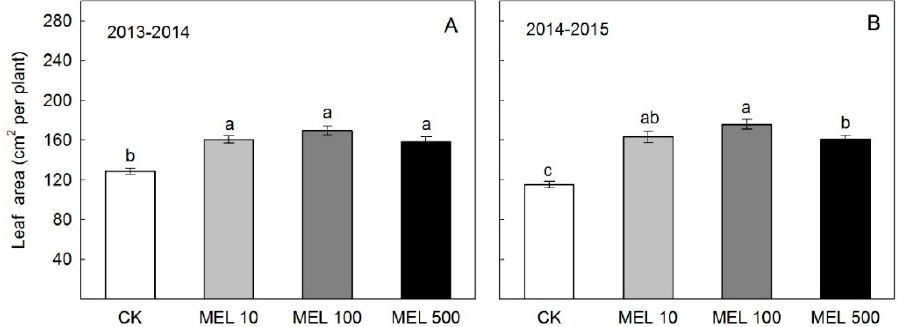
Figure 3. The effects of MEL application on leaf area at initial flowering stage in the 2013–2014 ( A ) and 2014–2015 ( B ) growing seasons. Values are means ± SEs of six replicates. Significant differences are indicated by different letters ( p < 0.05).